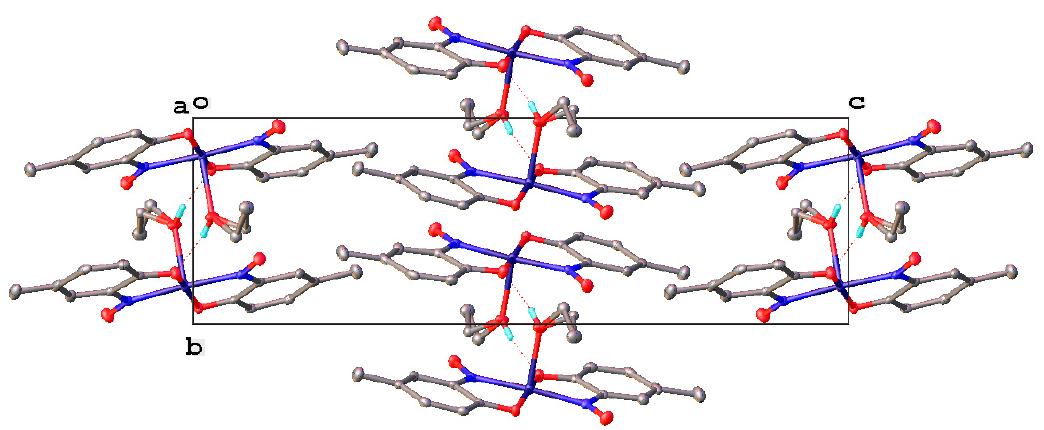
Figure 4. The unit cell of the obtained crystal structure of copper(II) bis (4-methyl-2-nitrosophenol) with ethanol as a solvate [41,51].